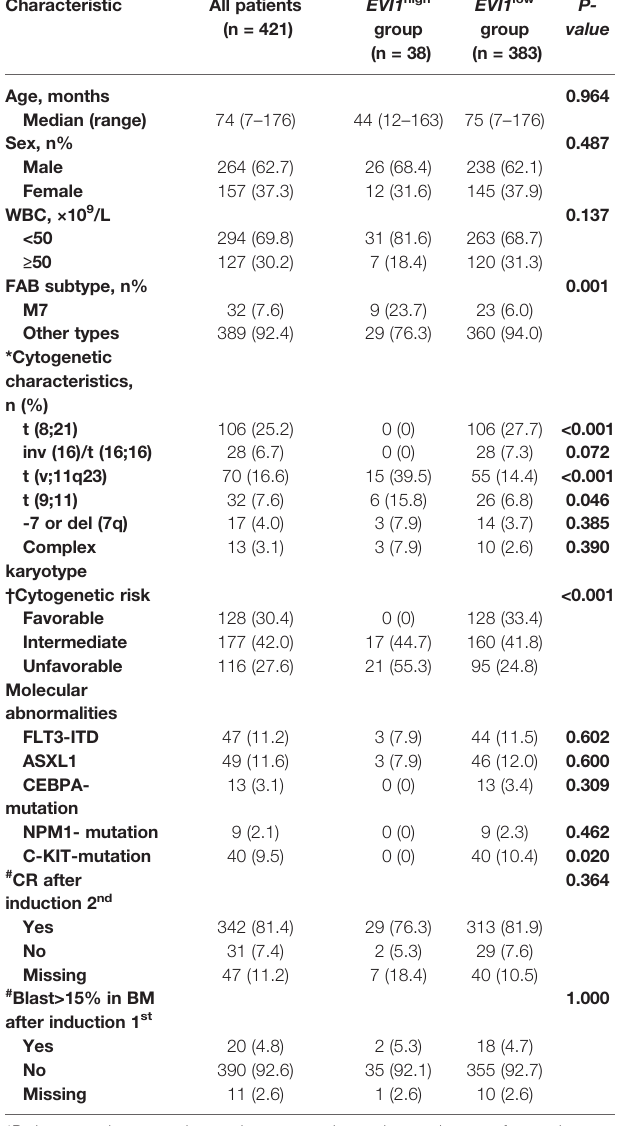
TABLE 1 | Clinical and genetic characteristics according to the EVI1 status.